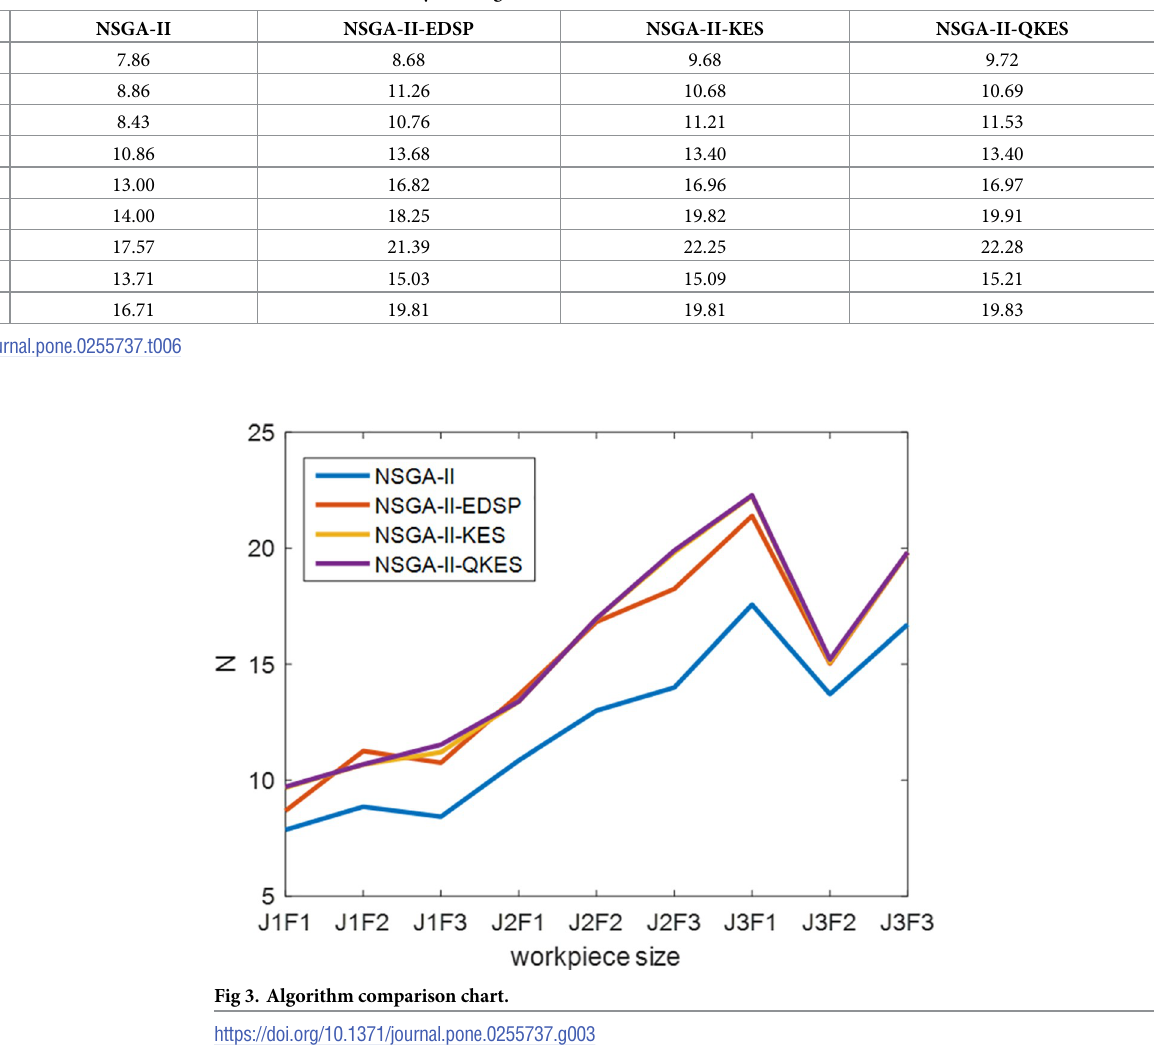
Table 6. Comparison of the number of non-dominant solutions obtained by each algorithm.